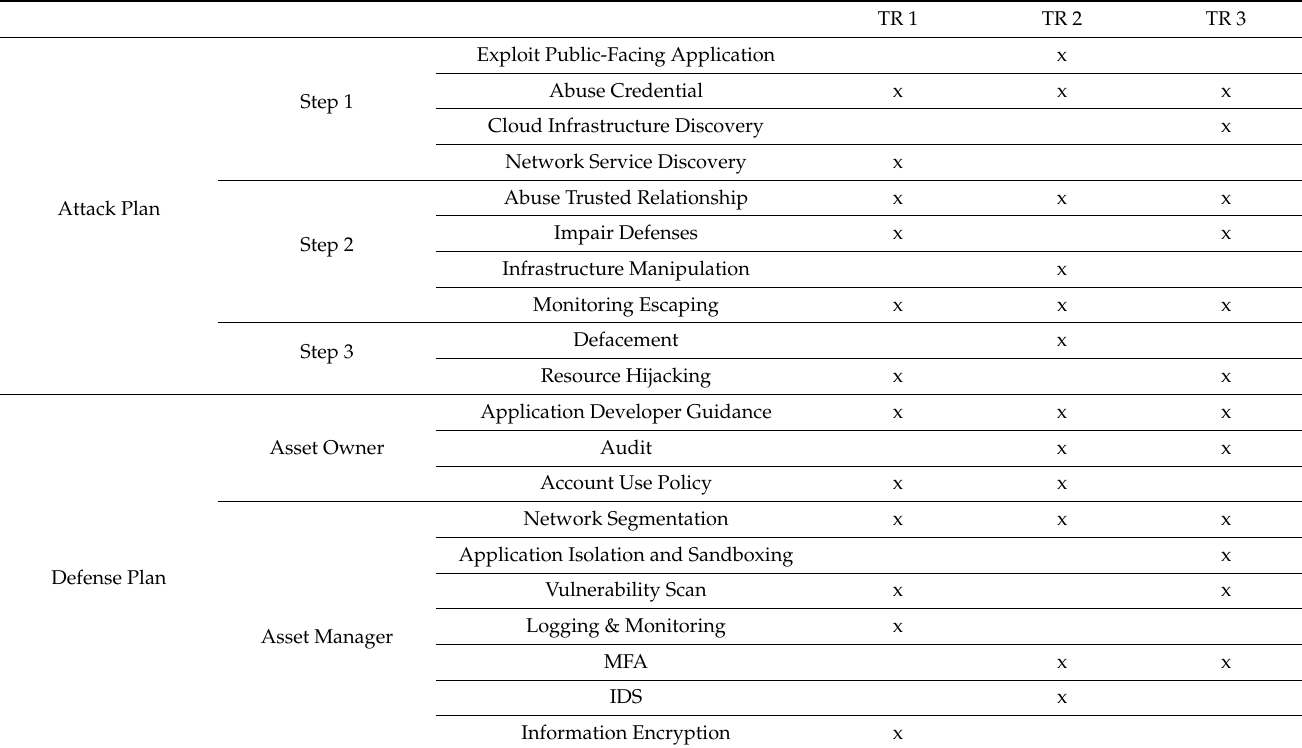
Table 3. Chosen cards in previous trail